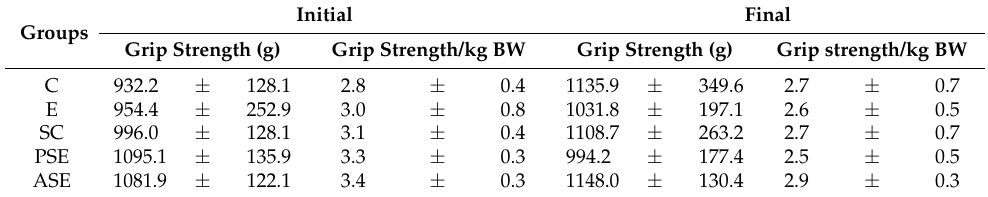
Table 6. Effects of synbiotics supplementation on grip strength (g) in rats with chronic ethanol feeding 1 . Groups